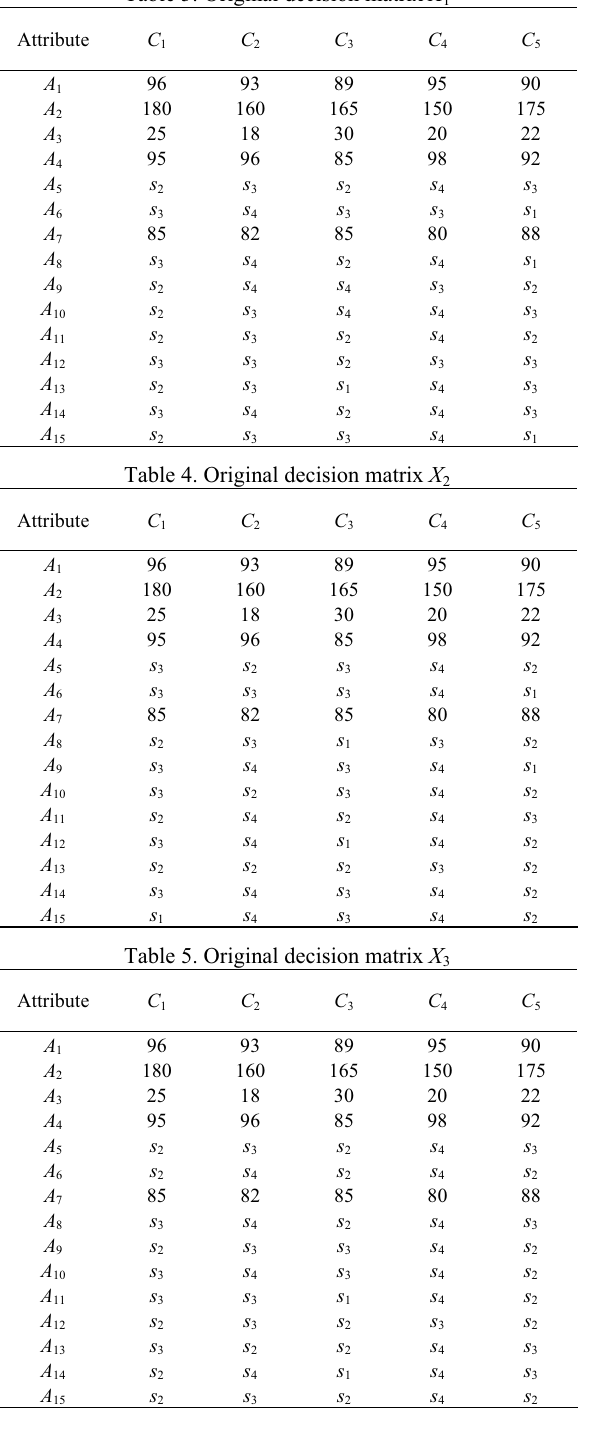
Table 3. Original decision matrix X 1